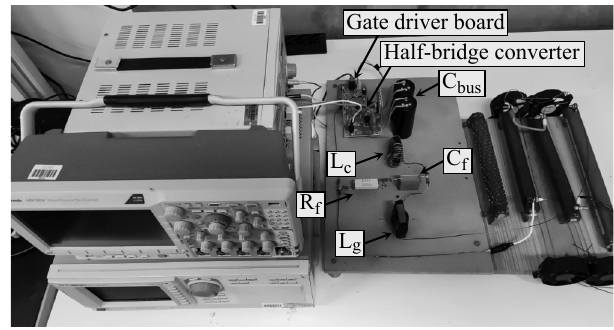
Figure 9. Prototype for experimental results.